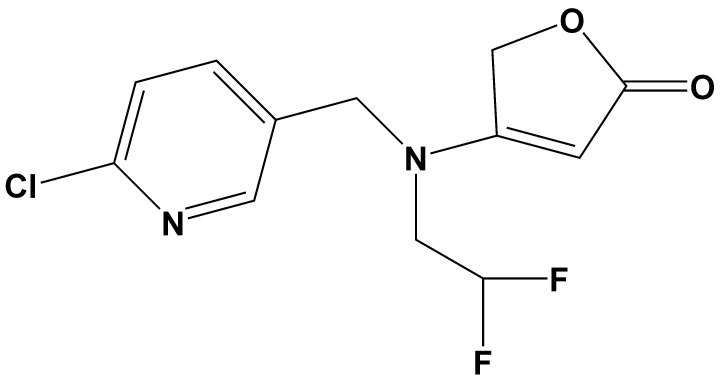
Flupyradifurone.